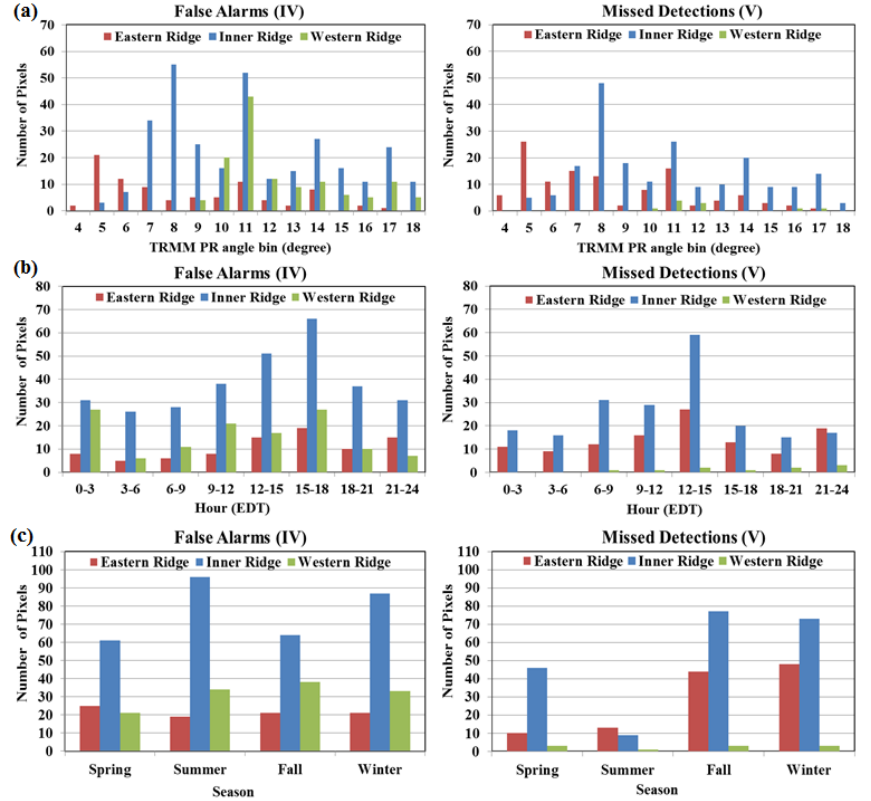
Figure 7. Histograms of FA (left panel) and MD (right panel) occurrences as a function of the viewing angle (a) , time of the day (b) and season of the year (c) . As previously, the colors correspond to raingauges aligned with the eastern (red, RG0XX), western (green, RG3XX) and inner ridges (blue, RG1XX) in the region of study (Fig. 1, Table